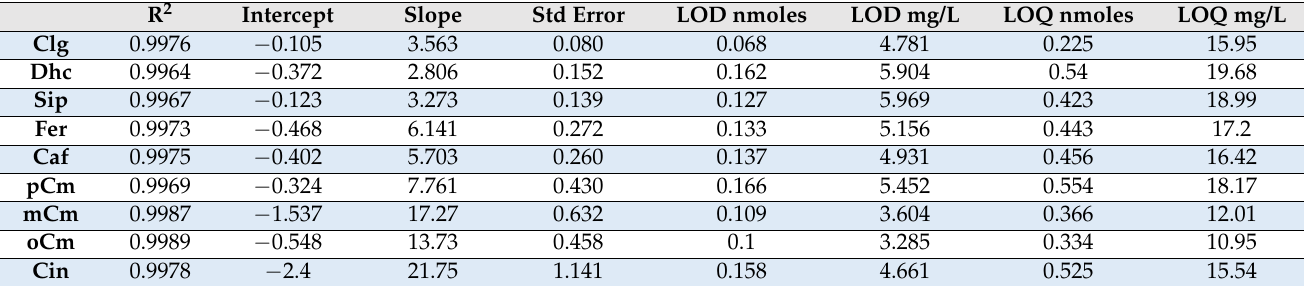
Table 7. Calibration parameters derived from linear regression equations using Tween